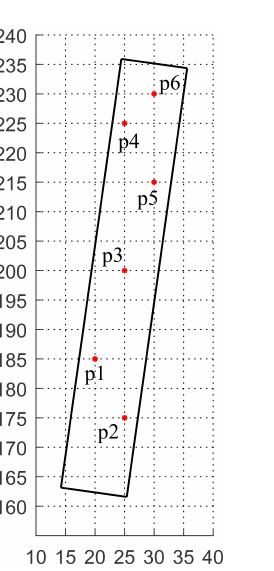
Figure 8. The inspection points selected on the worm gear tooth